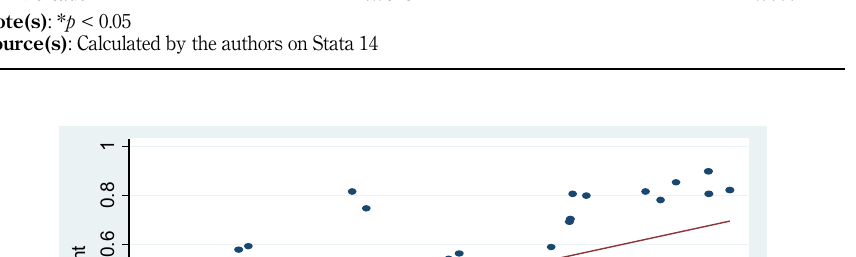
Table 8. Correlation between FII and index of FI from Park and Mercado